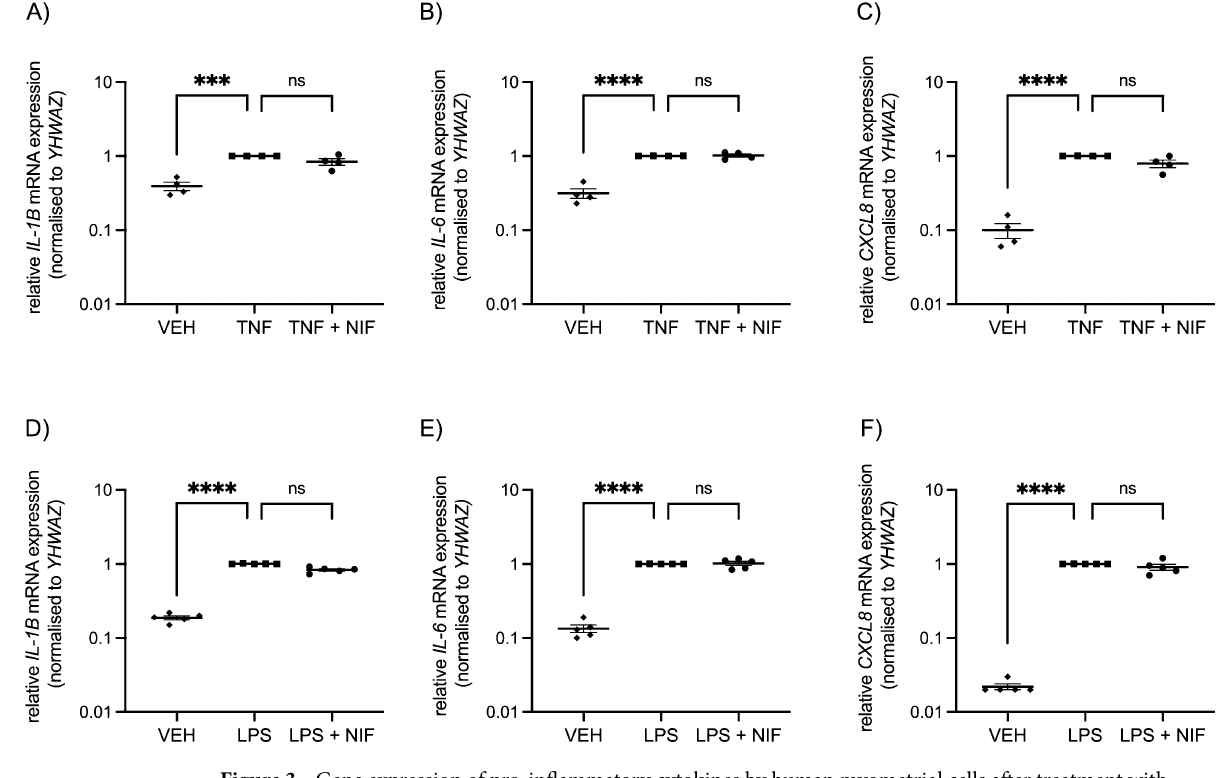
Figure 3. Gene expression of pro-inflammatory cytokines by human myometrial cells after treatment with vehicle control (VEH), TNF, LPS, and nifedipine (NIF). Treatment of myometrial cells with ( A–C ) TNF (0.1 ng/ ml) and ( D–F ) LPS (100 ng/ml) induces an increase in pro-inflammatory mRNA expression of IL-1B , IL-6 , and CXCL8. Addition of nifedipine (10 µM) does not reduce this upregulation. Data are presented as fold change calculated relative to that of TNF-treated cells ( A–C ) or LPS-treated cells ( D–F ). Treatments were performed in duplicate and individual data points represent the mean of those technical replicates ( n = 4 experiments ( A–C ) and n = 5 experiments ( D–F )). Data were assessed for statistical differences using one-way ANOVA followed by Dunnett’s multiple comparisons performed on the deltaCt (Ct of the gene of interest subtracted from the Ct of the YHWAZ reference gene). The error bars represent SEM, *** indicates P < 0.001, **** indicates P < 0.0001, and ns indicates no statistical